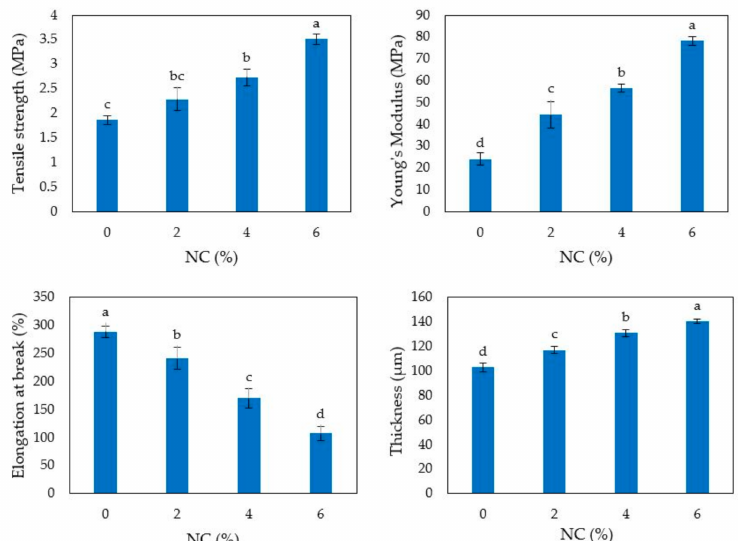
Figure 4. Tensile strength, elongation at break, Young’s module and thickness of hemp protein-based films derived from film forming solutions prepared at pH 9 and containing increasing amounts of egagropili nanocrystalline cellulose (NC). Di ff erent small letters a–d indicate significant di ff erences among the values reported in each column ( p < 0.05). Further experimental details are given in